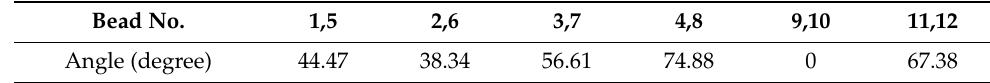
Table 1. The angles between the beads and membrane joint.